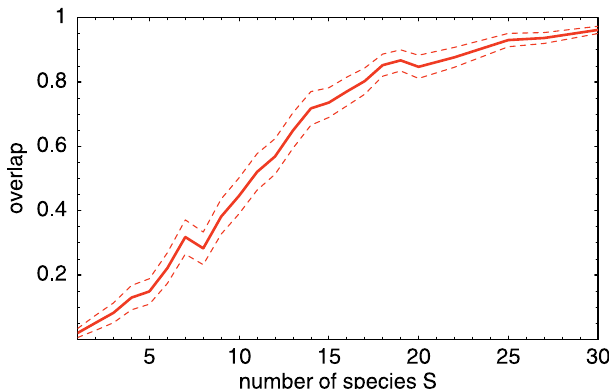
Figure 4. Performance of PhyloGibbs in Recovering a Single Site of a Randomly Chosen WM of Width w ¼ 10 from the Alignment of S Orthologous Intergenic Regions of Proximity q ¼ 0.5 and Length L ¼ 500 as a function of S The solid line shows the average overlap between the true site and the predicted site and the dotted lines show two standard errors. DOI: